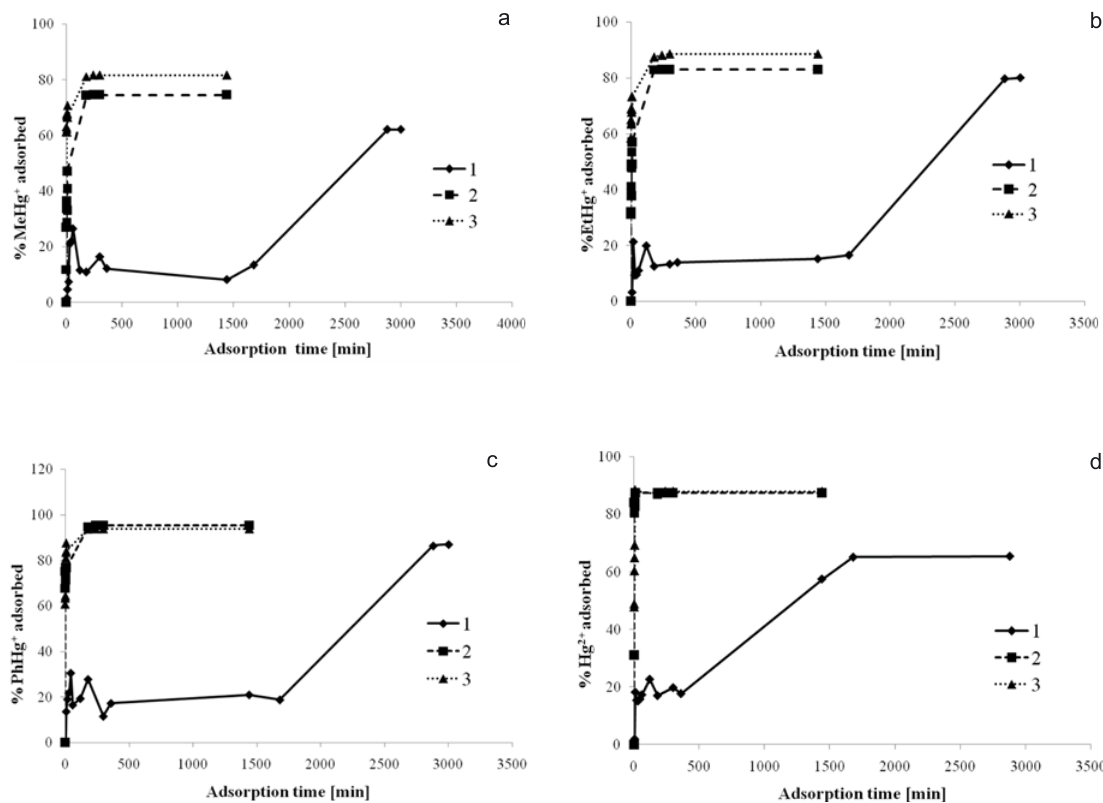
Figure 1. Effect of sediment/water mixture movement for (1) static system, (2) agitated system, (3) stirred system. 20 g of ZL 1606 sediment, T= 22.3°C, 250 mL of water, pH 5.2, Hg concentration 0.2 mg L -1 ; stirred